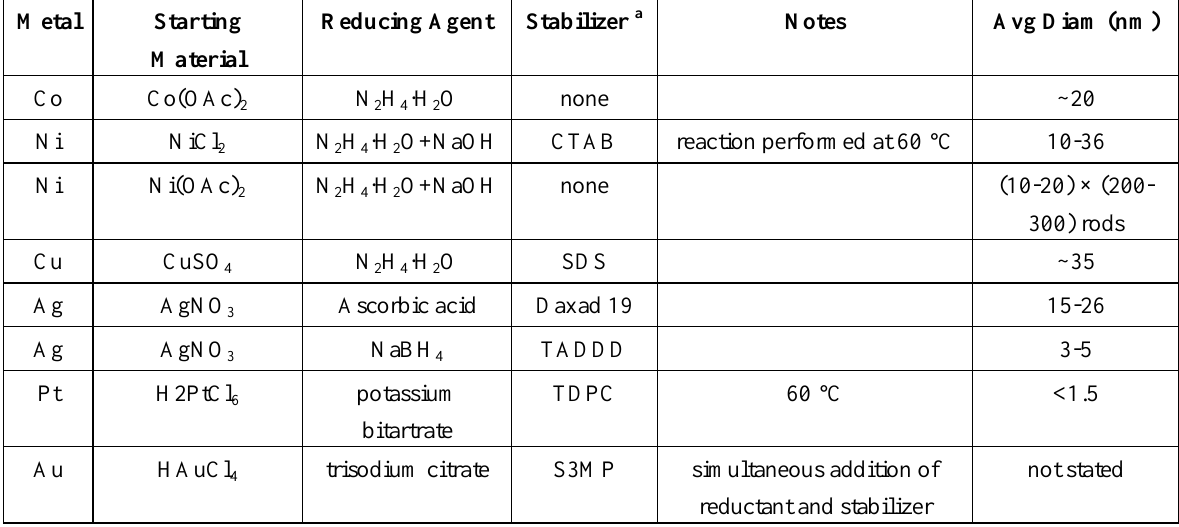
Table 1. Inorganic nanoparticles precipitated from aqueous solutions (adapted from [22]). Metal